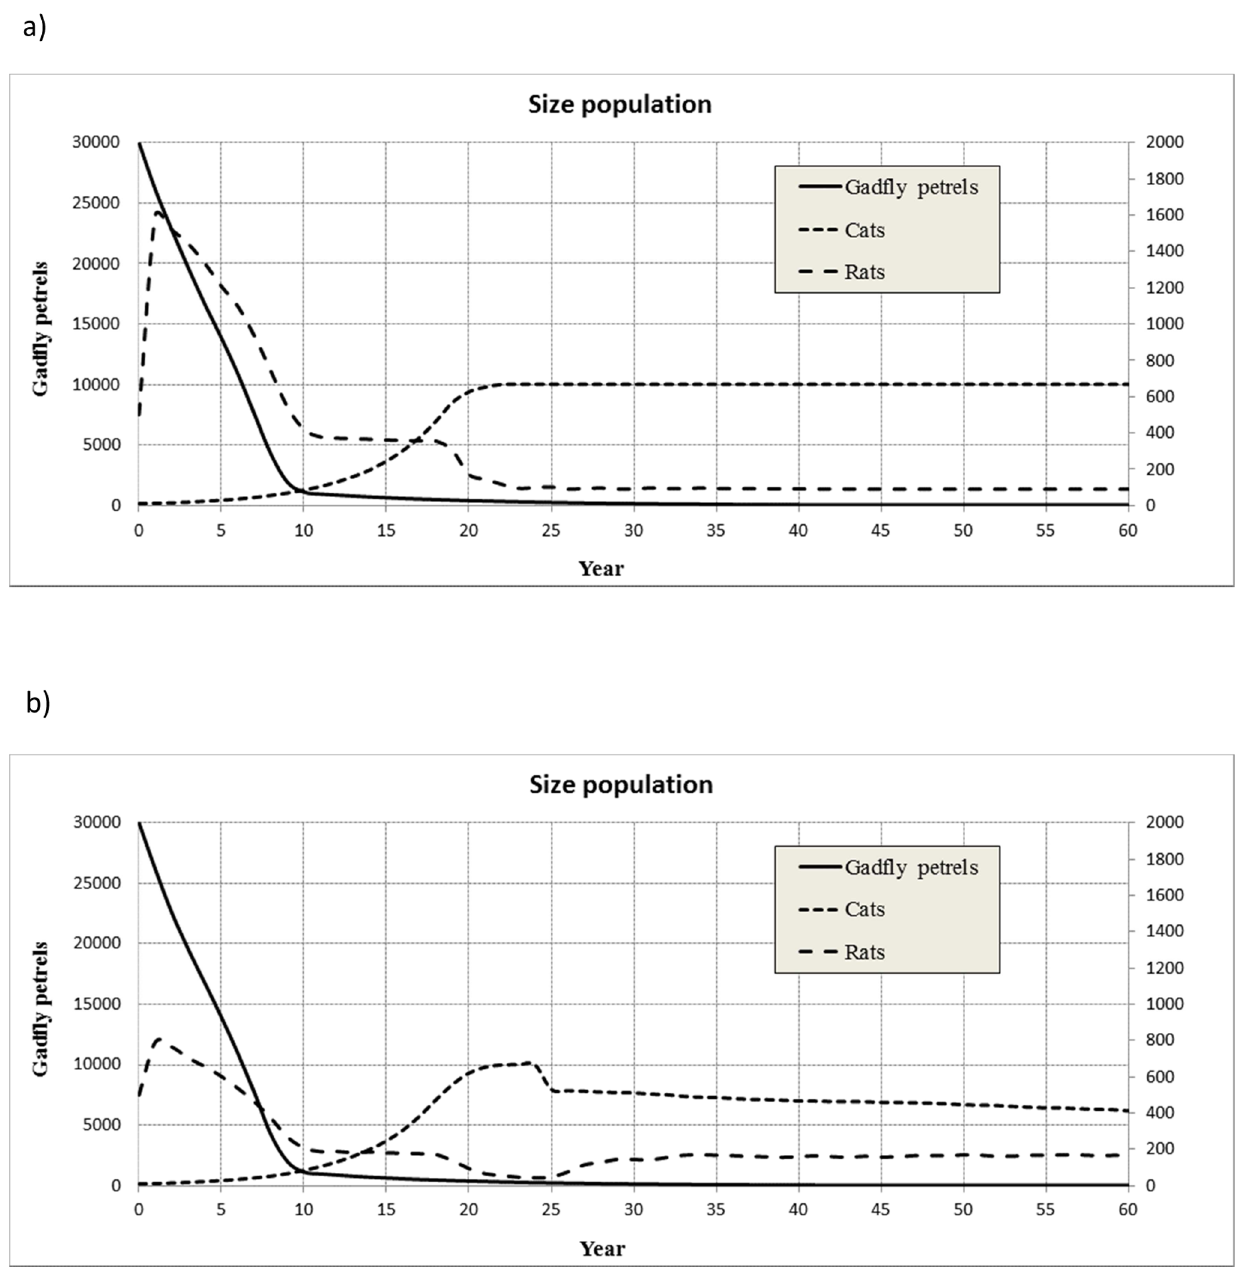
Figure 7. Population trend of gadfly petrels, cats and rats. The simulated scenario has been: gadfly petrels: 30 000, cats: 10 and rats: 500. The biological parameters used are shown in Table 1. a) Without human intervention, b) 50% of rats captured annually and from year 25 the 20% of cats are removed annually.